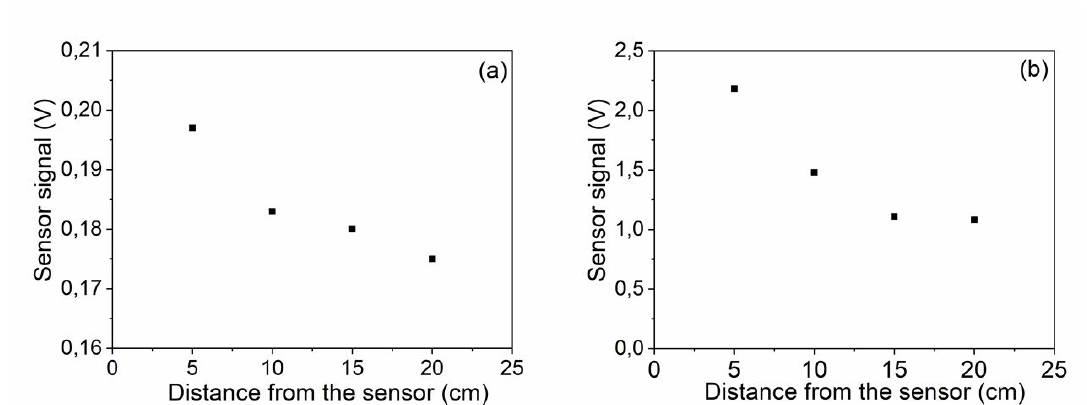
Figure 8. Sensor response to the massive ball drop as a function of the time for (a) 1-3 PUR/PZT sample with 15 vol.% (45 rods) and (b) 34 vol.% (90 rods) of PZT.